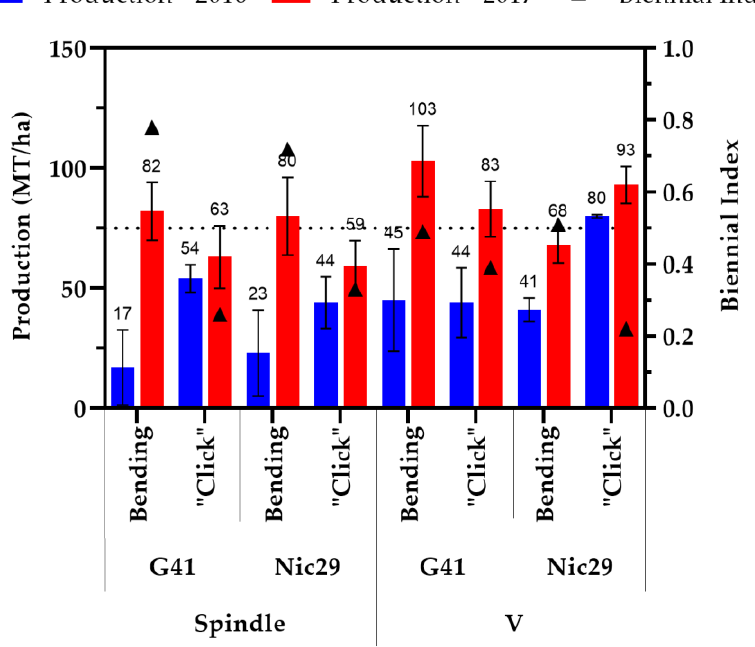
Figure 4. Yield (kg/tree) across all treatment combinations at harvest for “WA38” trees grown in Washington State in 2016 and 2017. ANOVA indicated no significance in 2016 and a significance of: * < 0.05 in 2017 (upper-cased letters). Student–Newman–Keuls (SNK) test for mean comparisons across all treatments within a given year. Means to the right of each bar in the chart with the same letter indicate non-significance at p -value < 0.05. No treatment differences in 2016, so no letters appear. Errors bars ± SE, N = 3 trees.